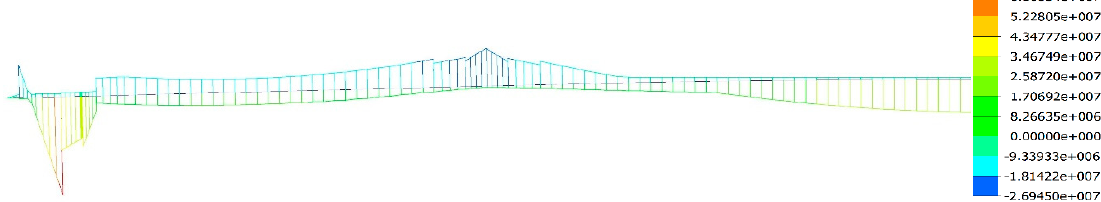
Figure 13. Moment envelope diagram of girder under the combined condition of dead and live loads (Unit: N·m).